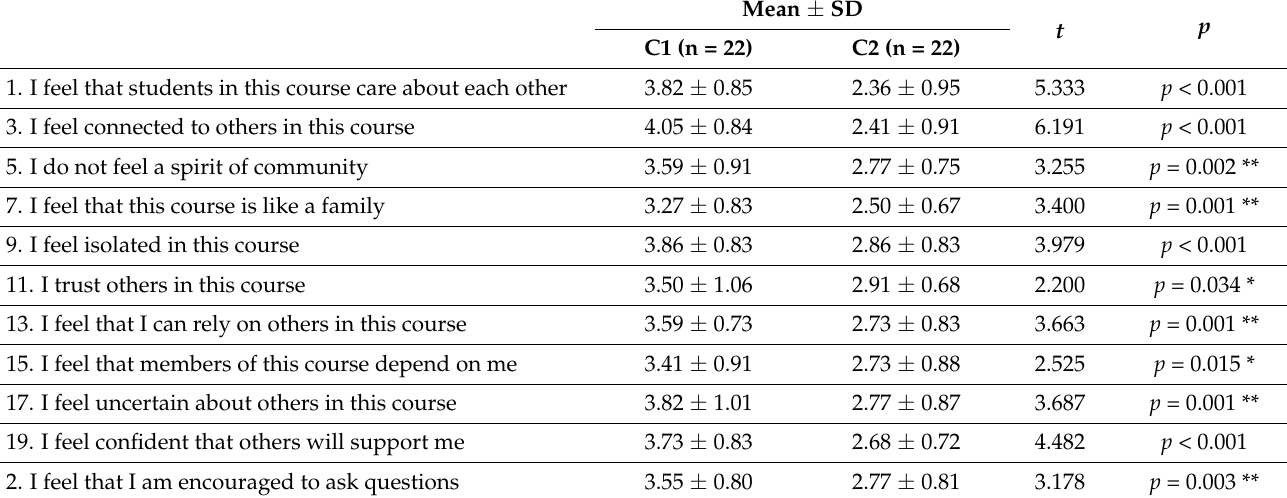
Table 6. Descriptive Statistics of the Classroom Community Scale